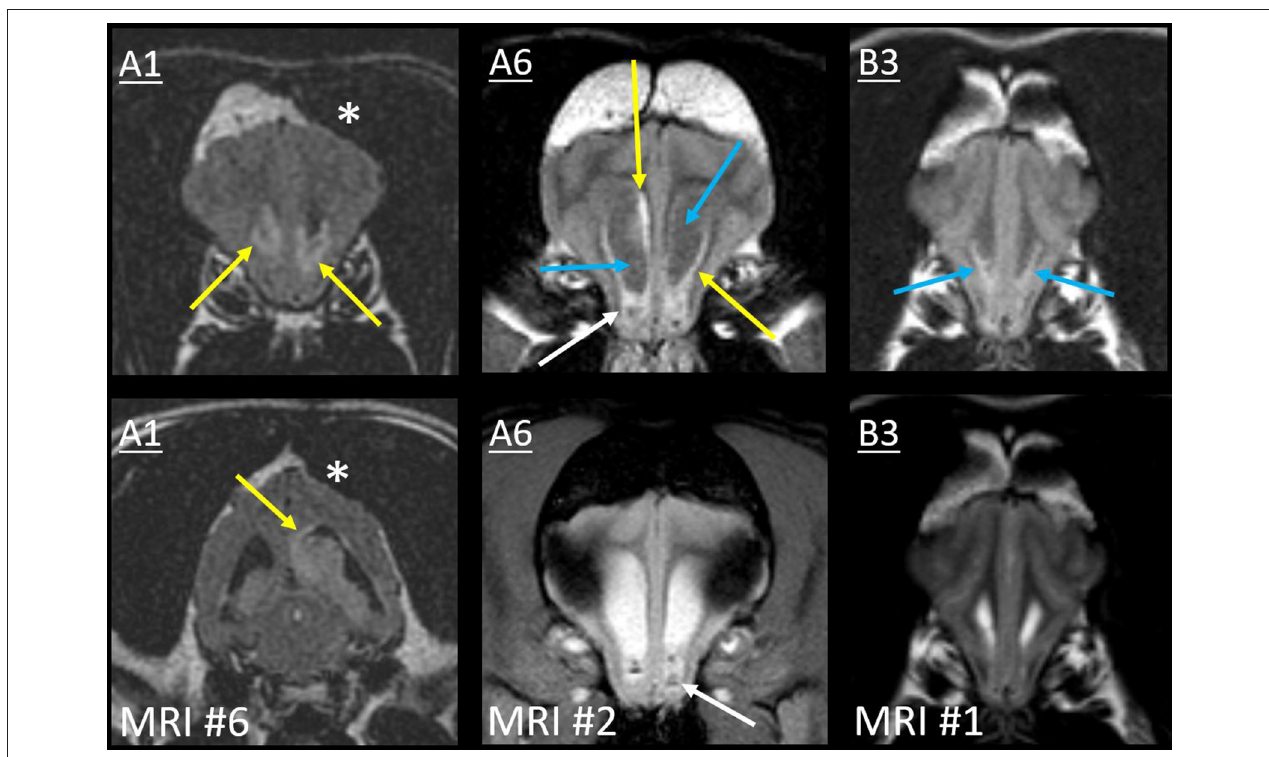
FIGURE 8 | Type II ependymal CSF drop metastasis. Images from Cases A1, A6, and B3 ( left, middle, and right) . Transverse MRIs at the level of the rostral horn (lower image of A1: level of the tail of the hippocampus). Images are T2W-FLAIR, except the lower images of A6 (T2*W GRE) and B3 (T2W). A surgical bone defect is evident (A1, asterisks). On FLAIR, ependymal hyperintensity incompletely surrounds the lateral ventricles (yellow arrows). Note the symmetrical failure of CSF suppression on FLAIR (blue arrows). In Case A1, there is a hippocampal nodule. Abnormal material pools bilaterally in the rostral horns of Case A6 (white arrows): it is heterogeneous on FLAIR with GRE signal voids. There are symmetrical magnetic susceptibility artifacts lateral to both ventricles due to the air-tissue interface of the frontal sinuses. In Case B3, T2W appearance of the rostral horns is unremarkable, yet no normal CSF is present on FLAIR (blue